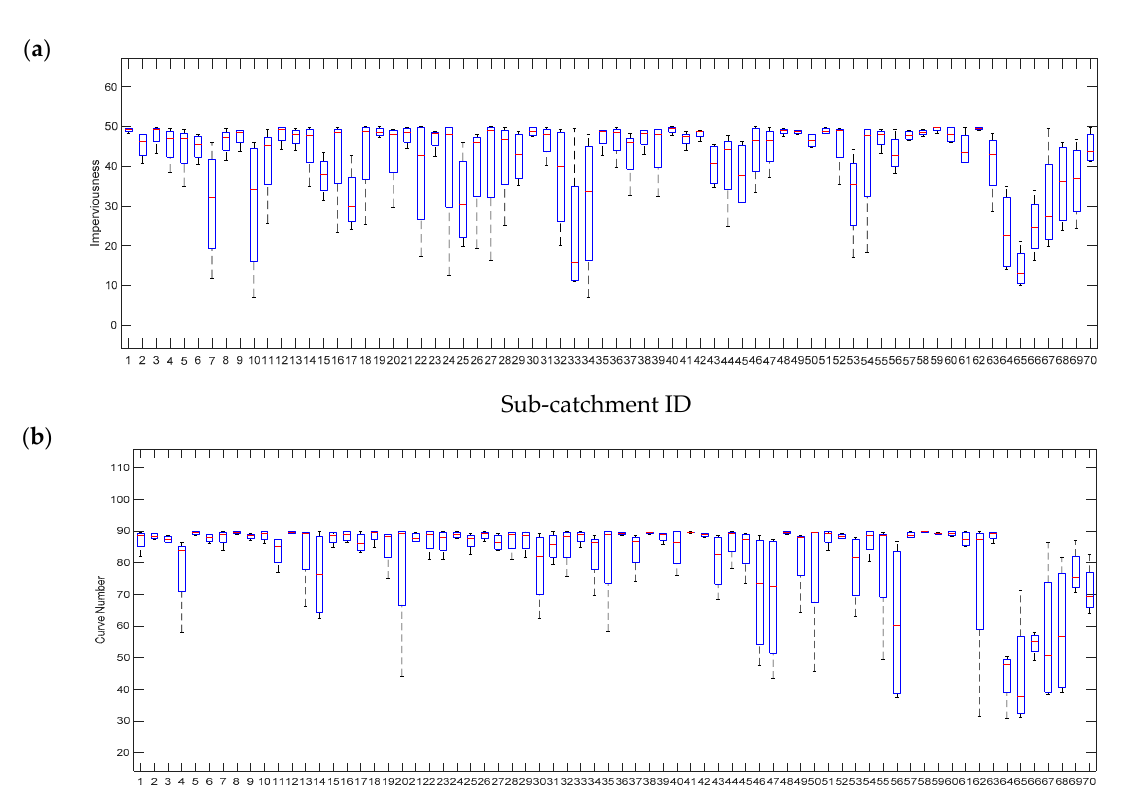
Figure 5. Box plots developed for ( a ) imperviousness and ( b ) curve number for 70 sub-catchments in the study area.